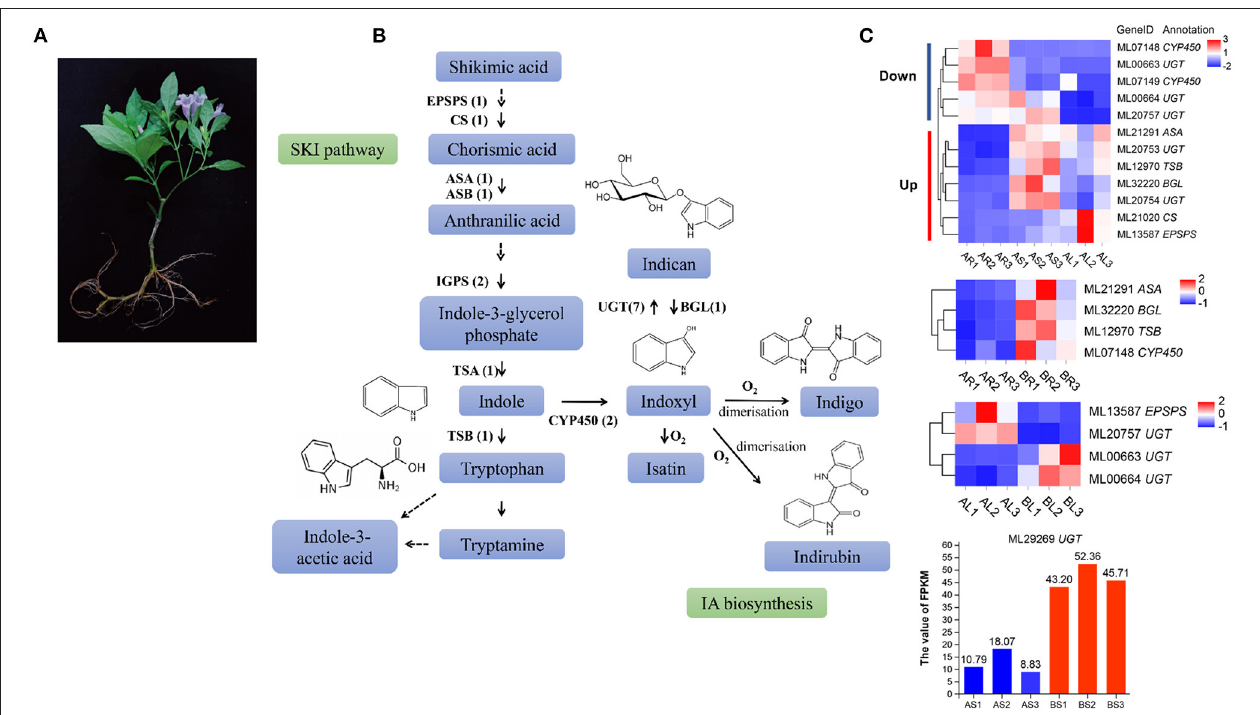
FIGURE 7 | Analysis of indole alkaloid (IA) biosynthesis in S. cusia . (A) S. cusia whole plant display. (B) Putative biosynthesis pathway of IAs in S. cusia . (C) Heat map showing the expression pattern of genes associated with IA biosynthesis in different tissues including the roots, stems, and